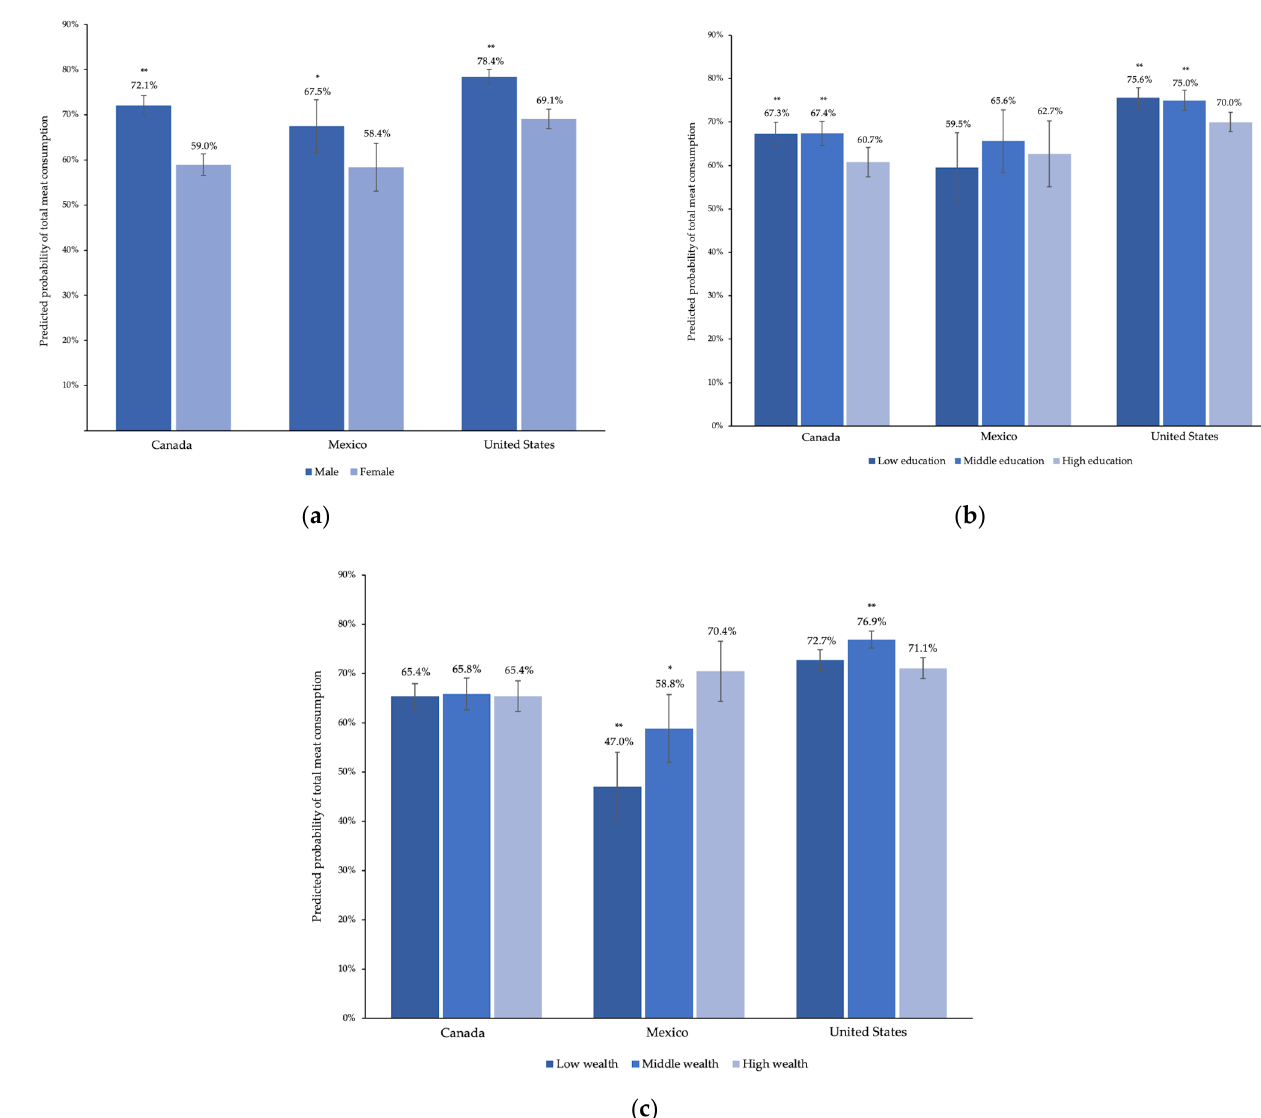
Figure 1. Adjusted predicted probability of total meat consumption by ( a ) sex, ( b ) education, and ( c ) wealth and income for one day of 24-h dietary recall data in Canadian Community Health Survey (2015), Mexico National Health and Nutrition Survey (2016), and US National Health and Nutrition Examination Survey (2013–2016). Multivariate negative binomial models were adjusted for sex, 10-year age category, educational attainment, and wealth and income category; * p < 0.01, ** p < 0.001 for the observed difference in predicted probability of any meat consumption.